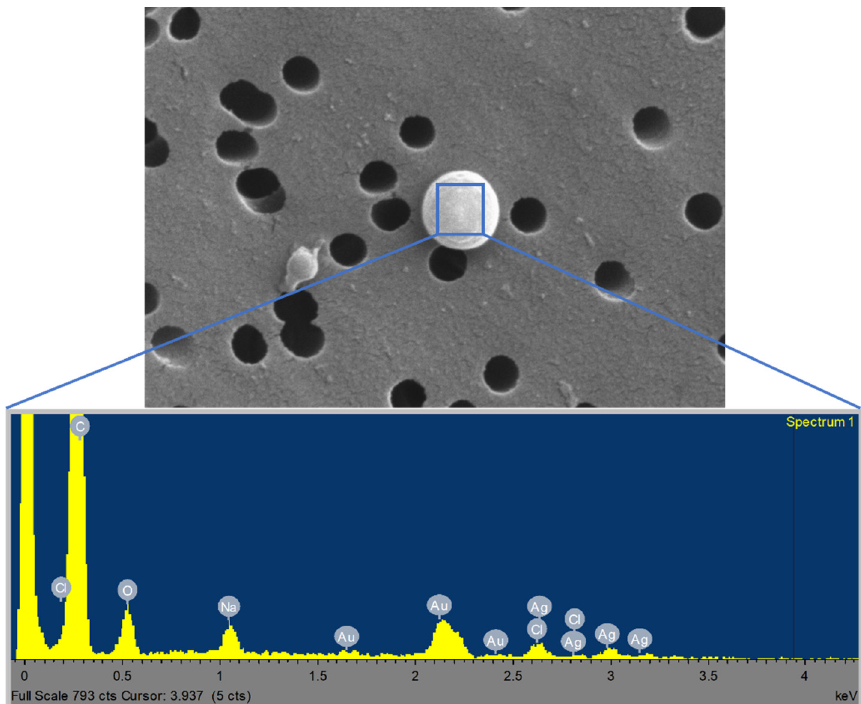
Figure 7. SEM images of ( a ) filter 1 (run 2 at 1 bar); ( b ) filter 2 (run 5 and 6 at 1.5 bar); ( c ) size distribution of AgHEC particles after spray-coating activities (mode: 0.39 µm), from SEM images.